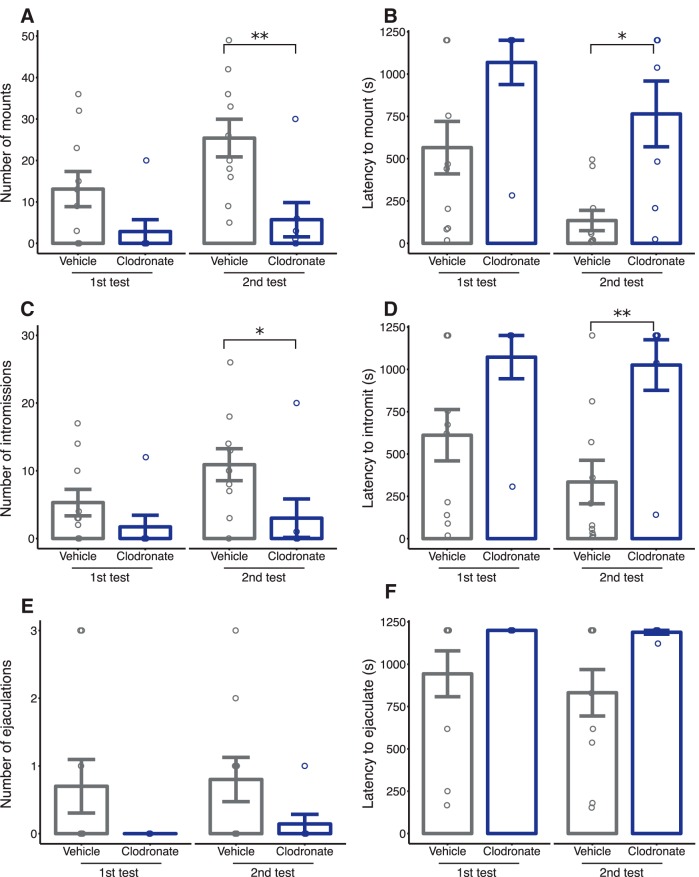
Postnatal microglia depletion induces deficits in adult male sex behaviors. Quantification of various components of male sex behavior including number of mounts (a), latency to first mount (b), number of intromissions (c), latency to first intromission (d), number of ejaculations (e), and latency to first ejaculation (f). Solid bars indicate group means ± SEM for VEH-treated (black) and LC-treated (blue) male rats. Open circles represent data from individual rats. *p < 0.05, **p < 0.01. n = 7–10 per treatment.